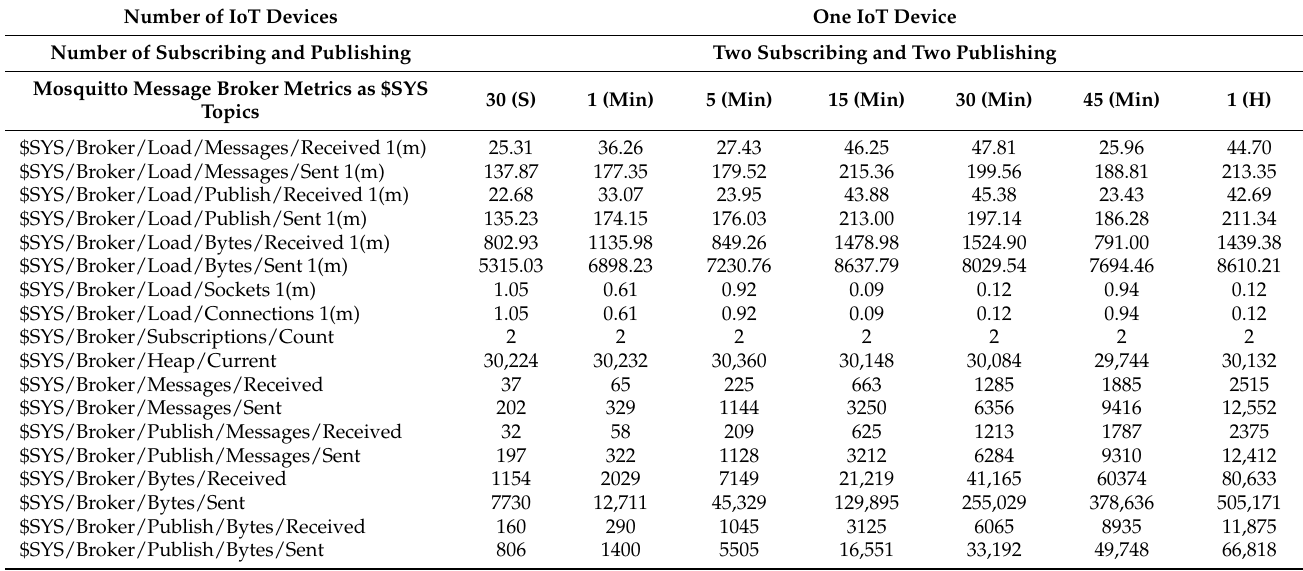
Table 4. Mosquitto message broker metrics on the fog layer using a bridge—first architecture.